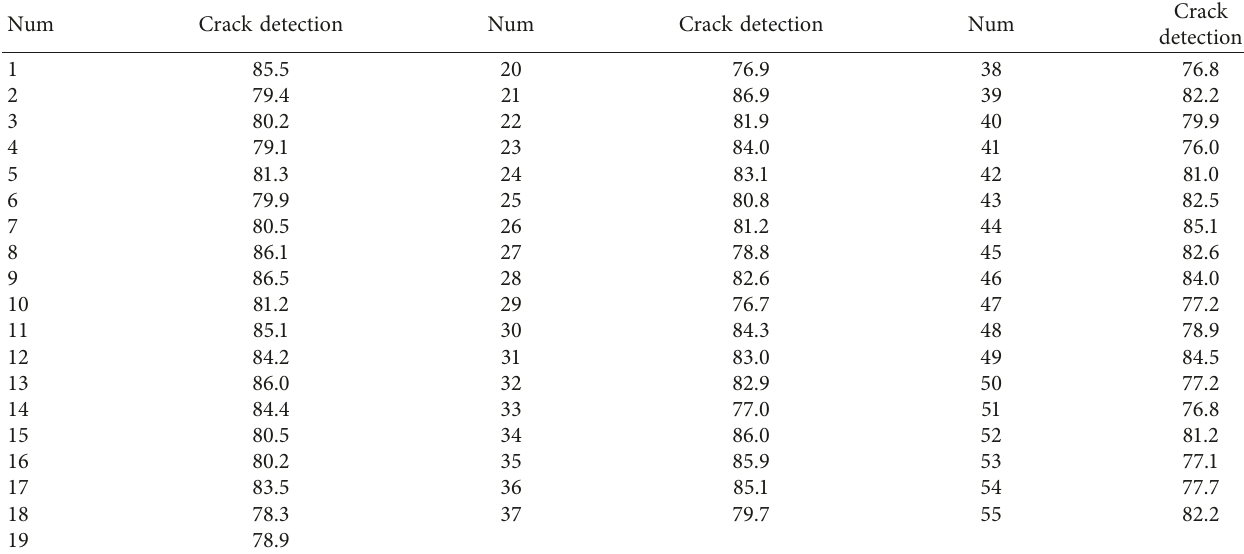
Table 1: The effect verification of the automatic detection method of building cracks based on digital image processing technology and multiscale feature analysis automatic detection